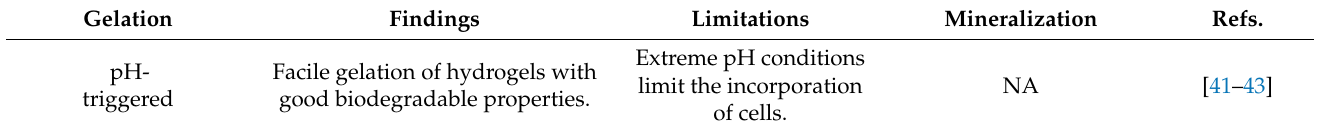
Table 1. The summary of different preparation methods of BSA-based hydrogels and their find- ings.